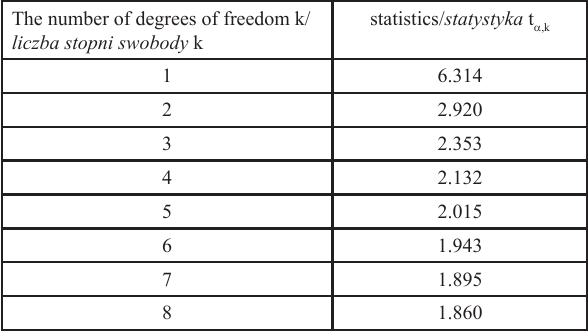
statistics/ statystyka t a ,k